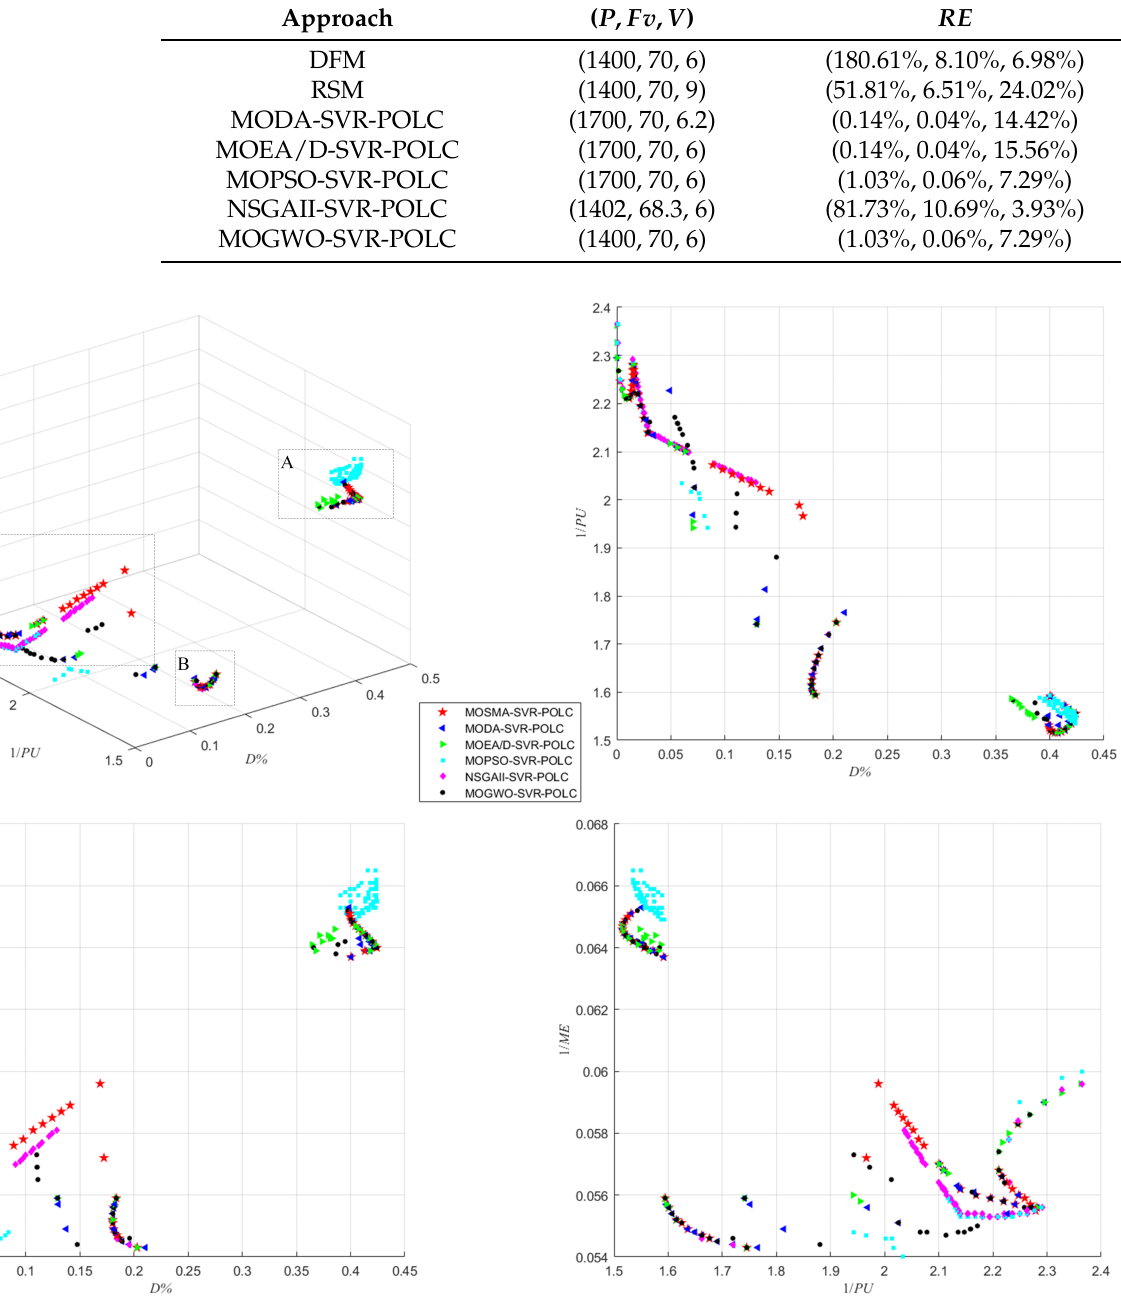
Figure 7. Pareto optimal front obtained by MOSMA-SVR-POLC and its similar